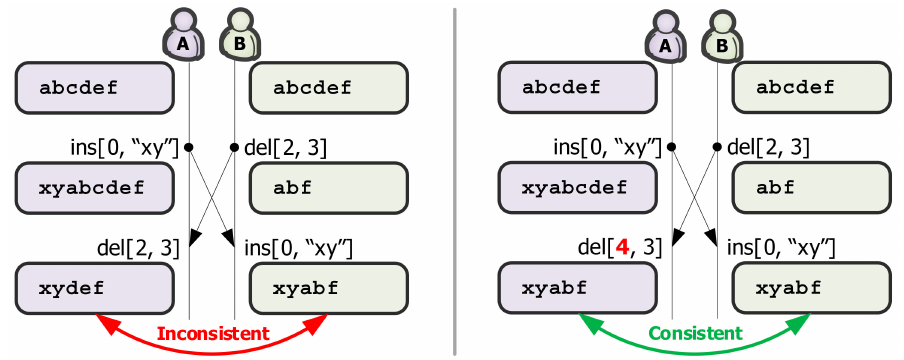
Figure 1. A simple example of operational transformation for consistency